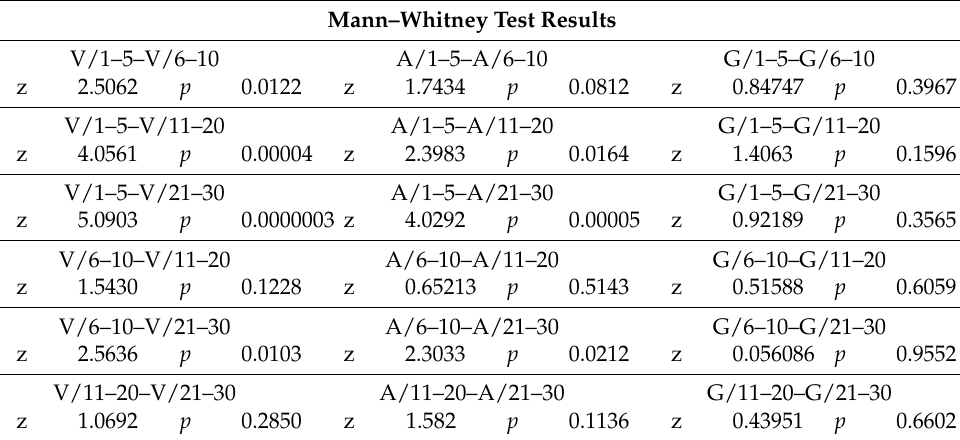
Figure 2. Changes in the total number of species in the studied age groups of abandoned lands (V—vineyards, A—arable land, G—grasslands). Table 1. Statistical results of the total species richness of abandoned land types for the studied age groups (V—vineyards, A—arable land,